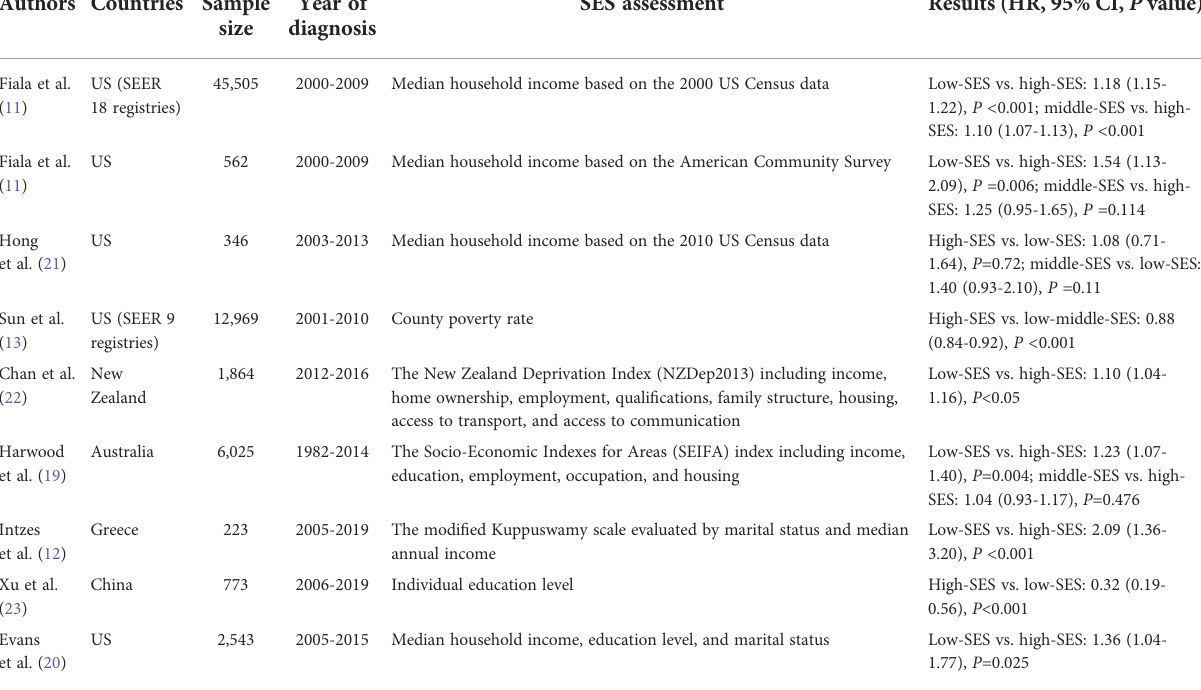
TABLE 6 A summary of other major studies regarding the association of SES with OS in MM patients. Authors Countries Sample